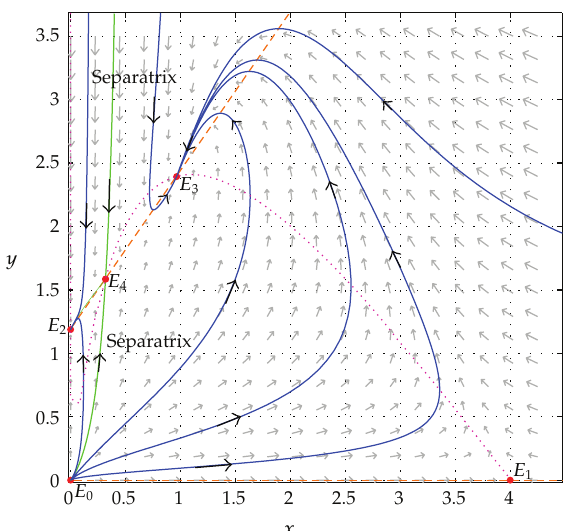
Figure 1: The phase portraits of model (cid:4) 1.3 (cid:5) . The parameters are taken as a (cid:6) 2 , b (cid:6) 0 . 25 , c (cid:6) 0 . 875 , e (cid:6) 1 , m (cid:6) 0 . 95 , and n (cid:6) 0 . 75 , f (cid:6) 0 . 8. In this case, E 0 (cid:6) (cid:4) 0 , 0 (cid:5) is a source, E 1 (cid:6) (cid:4) 4 , 0 (cid:5) and E 4 (cid:6) (cid:4) 0 . 31772 , 1 . 5846 (cid:5) are saddle points, and E 2 (cid:6) (cid:4) 0 , 071429 (cid:5) is a nodal sink, which is stable. The positive equilibrium E 3 (cid:6) (cid:4) 0 . 96454 , 2 . 3932 (cid:5) is locally asymptotically stable. The dashed curve is the x -nullcline f (cid:4) x,y (cid:5) (cid:6) 0, and the dotted curve is the y -nullcline g (cid:4) x,y (cid:5) (cid:6)